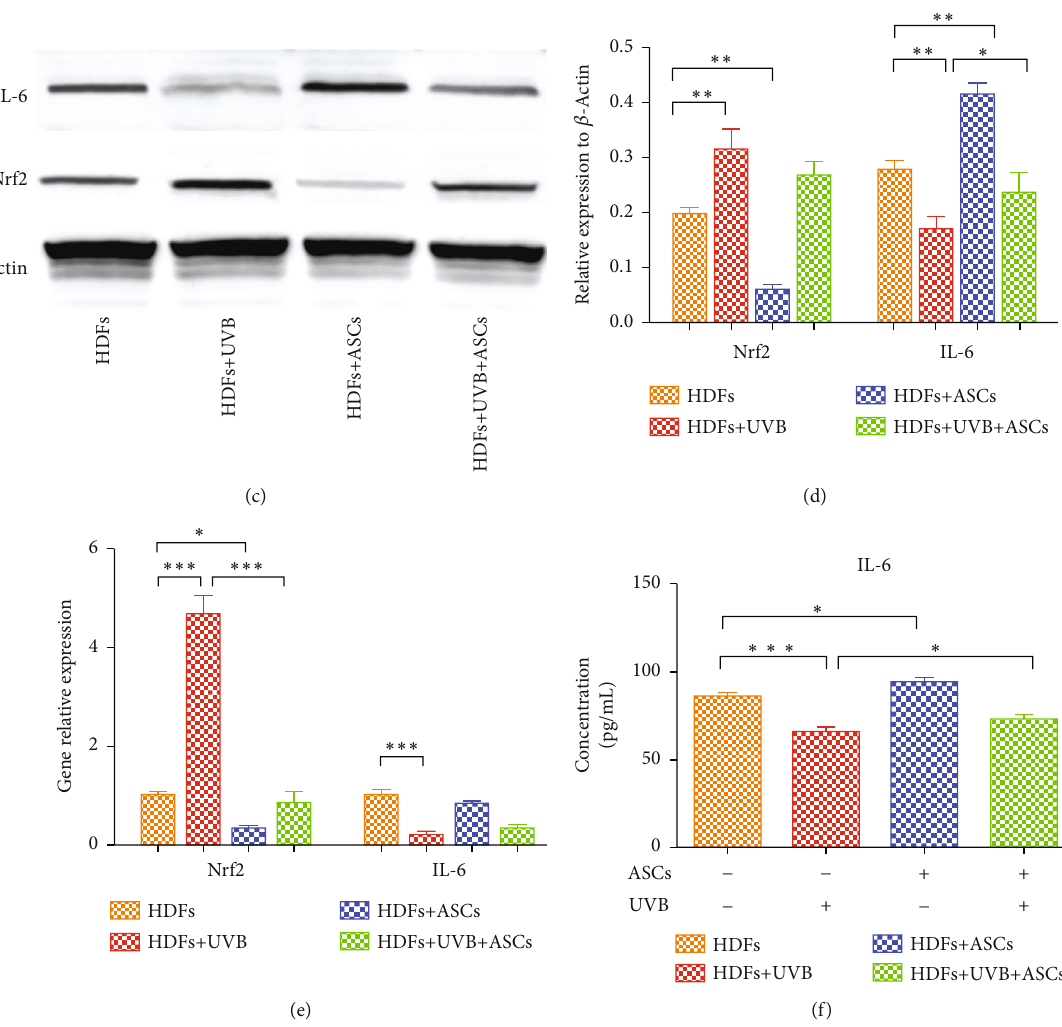
Figure 4: Assessment of oxidative stress in HDFs cocultured with ASCs. (a) Flow cytometry showing the reactive oxygen species (ROS) levels in HDFs. (b) Quanti fi cation of ROS-positive cells. (c) Western blots showing Nrf2 and IL-6 expression in HDFs. (d) Western blots quanti fi cation of Nrf2 and IL-6. (e) RT-PCR analysis of Nrf2 and IL-6 gene expression in HDFs. (f) ELISA results showing the expression of IL-6 in the cell culture